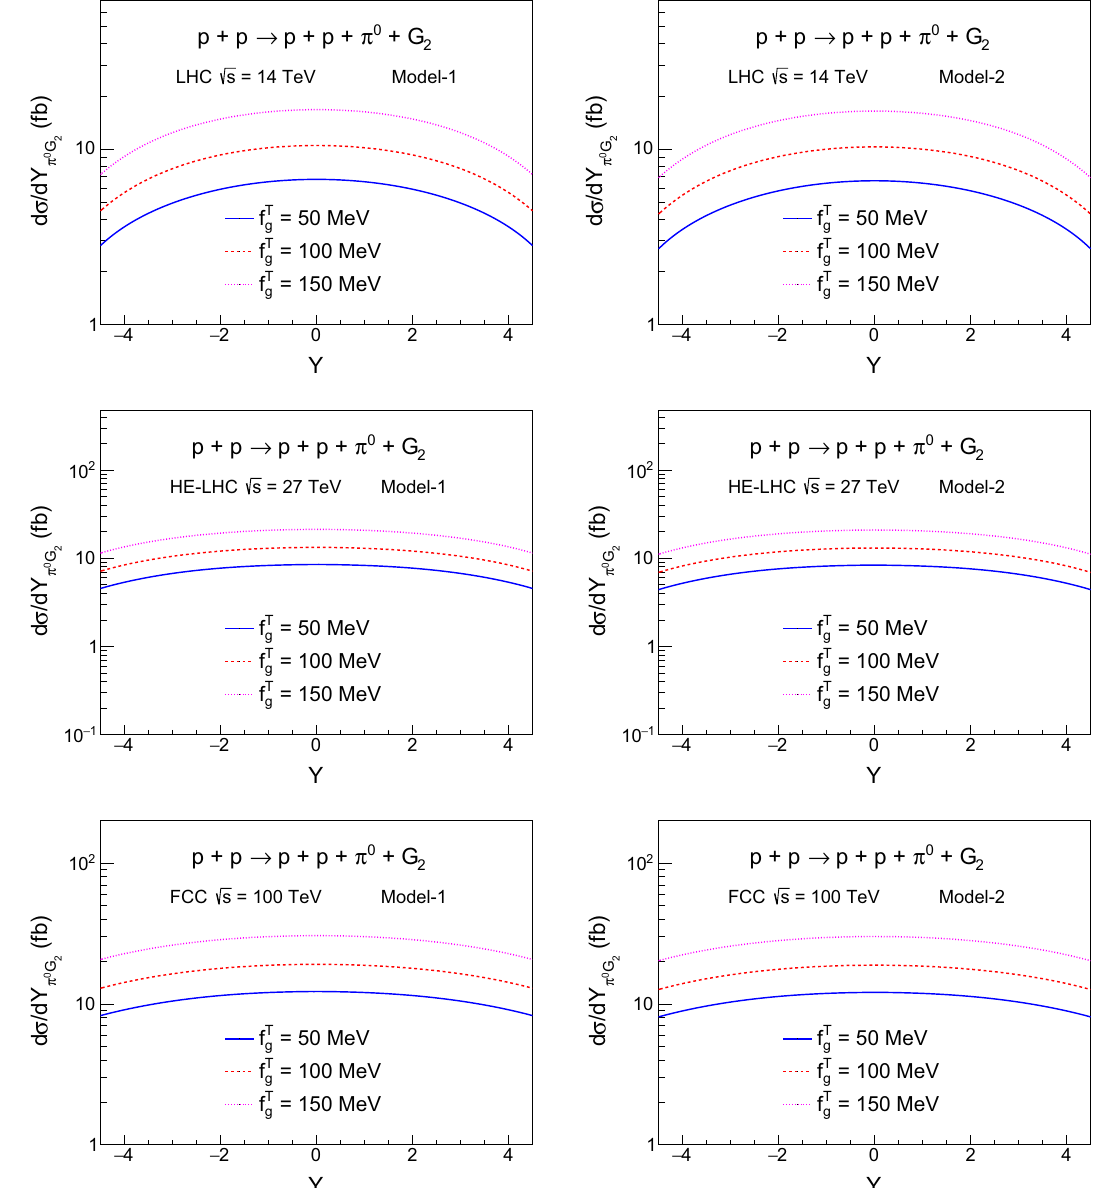
Fig. 4 Rapidity distributions for the UPC process p + p → p + p + G 2 + π 0 withmodel-1(leftpanels)andmodel-2(rightpanels).Fromtop to bottom, it represents the predictions for the LHC, HE-LHC and FCC